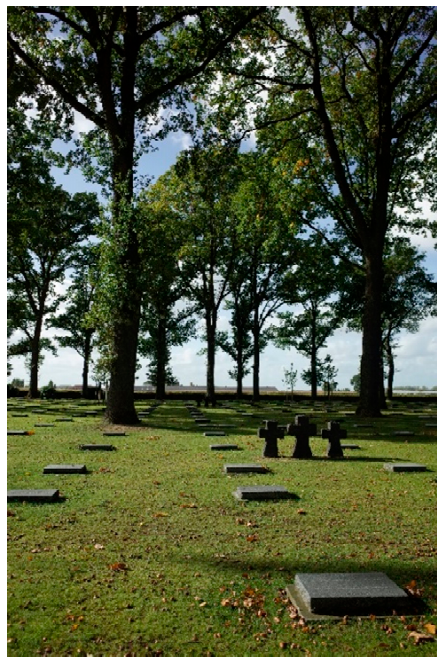
Figure 8. Deutscher Soldatenfriedhof in Langemark Belgium: an open and accessible graveyard with a spiritual character defined by a grid of horizontal tombstones and the vertical presence of full grown trees.